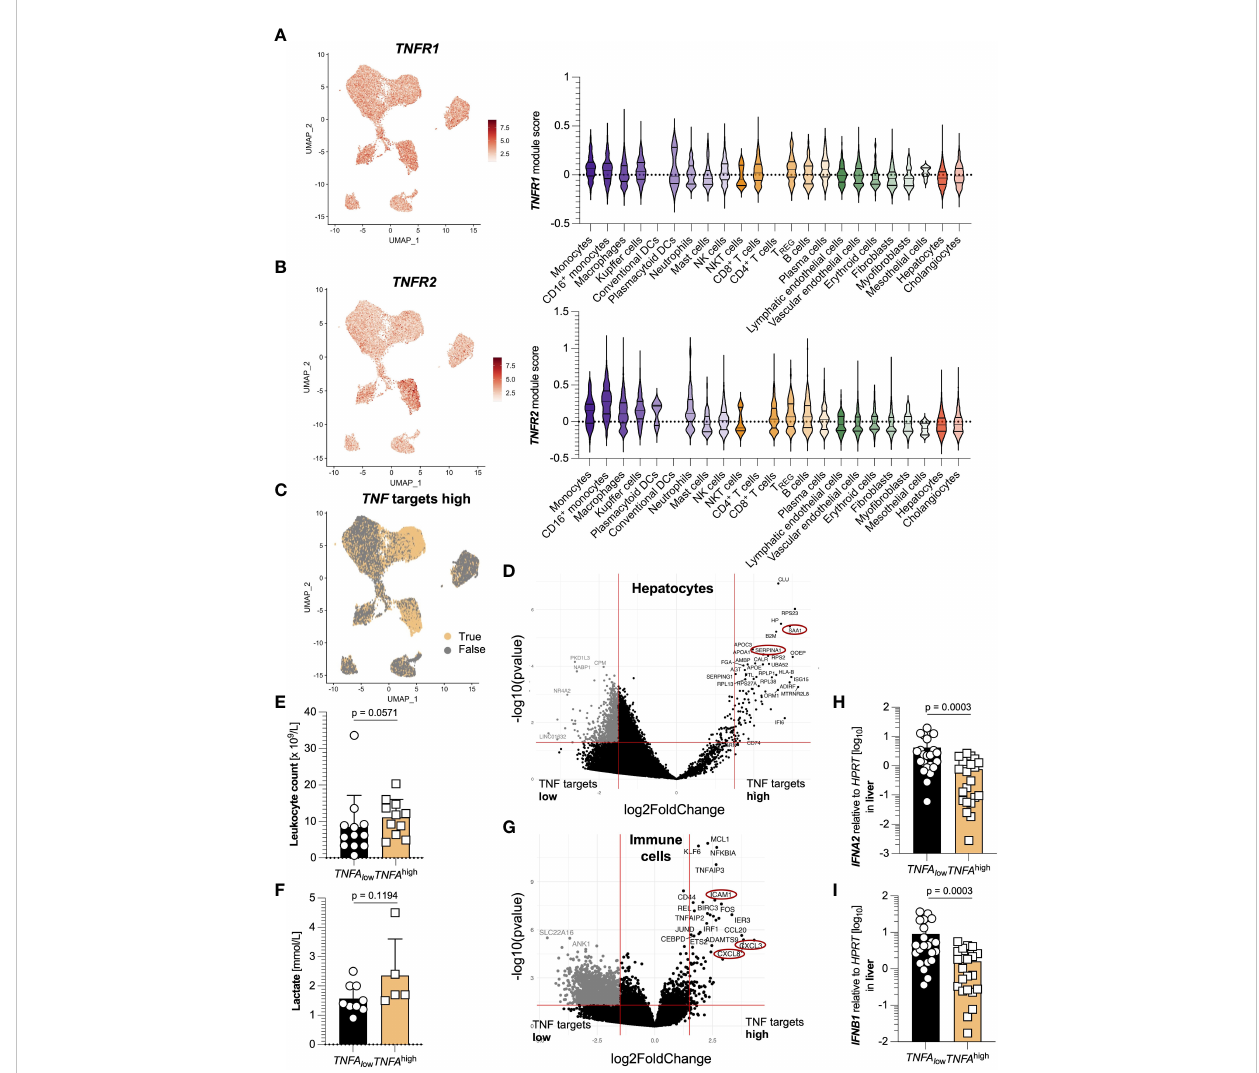
FIGURE 3 TNFA -responsive hepatocytes and immune cells are transcriptionally distinct. (A) Left: TNFR1 expression in cell clusters from the livers of 15 SARS-CoV-2 infected patients identi fi ed using single-cell sequencing; right: TNFR1 expression divided by cell cluster. (B) Left: TNFR2 expression in cell clusters from (A) ; right: TNFR2 expression divided by cell cluster. (C) Elevated expression of TNFA -associated target genes in clusters from (A) . (D) Volcano plot highlighting the differences in the clusters of hepatocytes from (A) between elevated and non-elevated expression of TNFA -associated target genes. (E, F) First available levels of (E) leucocyte count (x10 9 /L, n=23) and (F) lactate (in mmol/L, n=14) upon SARS-CoV-2 diagnosis, determined by screening of patient´s laboratory fi ndings, divided according to low (below the median of all 44 patients, black) and high (above the median of all 44 patients, yellow) expression of hepatic TNFA . Statistics by Mann-Whitney test. (G) Volcano plot highlighting the differences in the clusters of immune cells from (A) between elevated and non- elevated expression of TNFA -associated target genes. (H, I) Relative expression of (H) IFNA2 and (I) IFNB1 in the liver of patients divided according to low (below the median, n=22, black) and high (above the median, n=22, yellow) relative expression of TNFA mRNA in the liver. Statistics by Mann-Whitney test. Horizontal lines represent means ± SEM; each symbol indicates one sample from one patient. ns, not signi fi